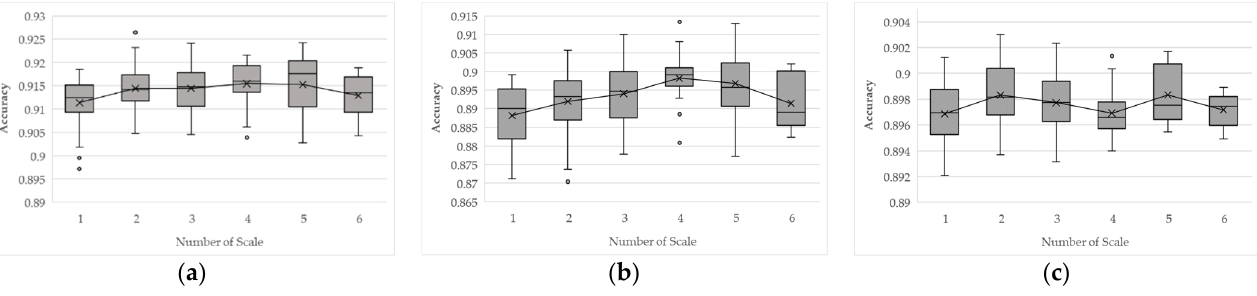
Figure 12. The accuracy performance on RWC ( a ), JMD ( b ), and Mir1k ( c ) with the different number of scales of the spectrogram.